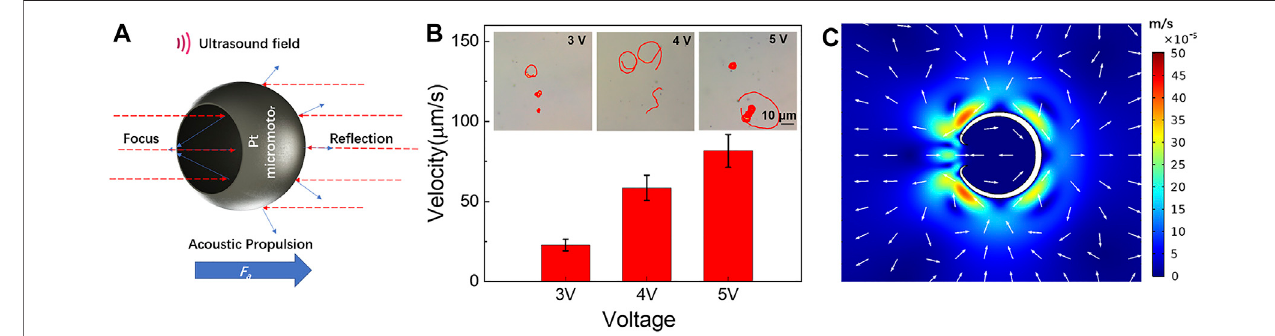
FIGURE4 |(A) Schematic ofthe acoustic propulsions ofthe micromotor under ultrasound stimulation. (B) The in fl uence ofthe voltage of the3 MHz ultrasound on the speed of the micromotors and track-lines of such motors under the corresponding voltage of 3 MHz ultrasound in 3 s (taken from Supplementary Video S2 ). (C) Acoustic streaming fl ow around the hemispherical shell in acoustic fi eld.